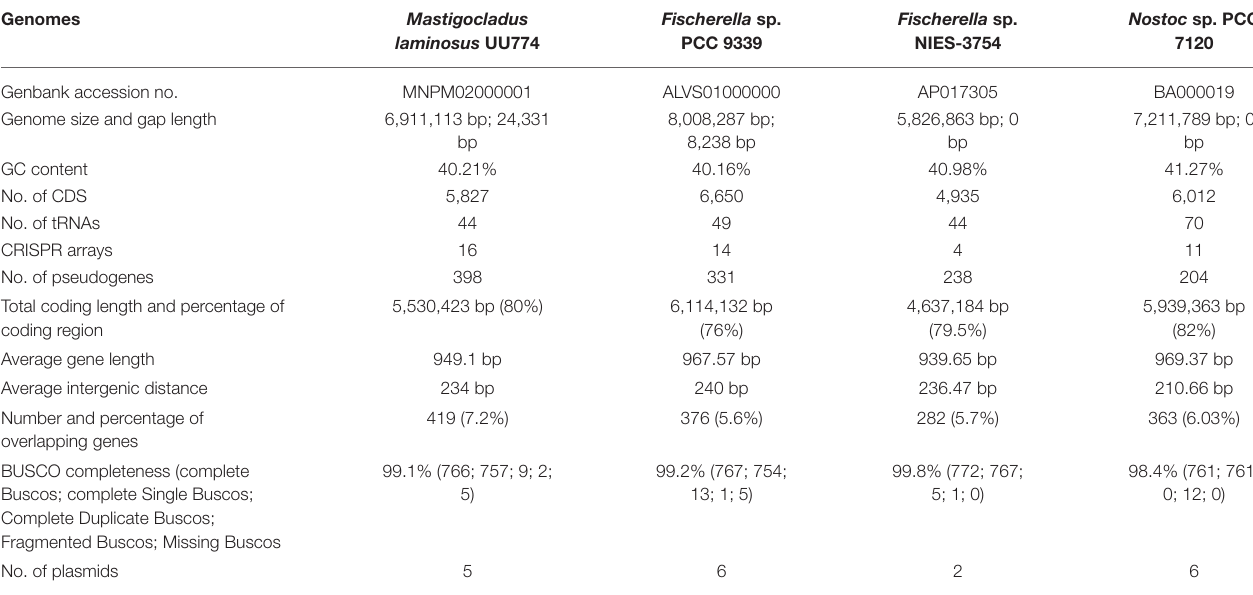
TABLE 1 | Genome statistics of UU774, PCC 9339, NIES-3754, and PCC 7120.